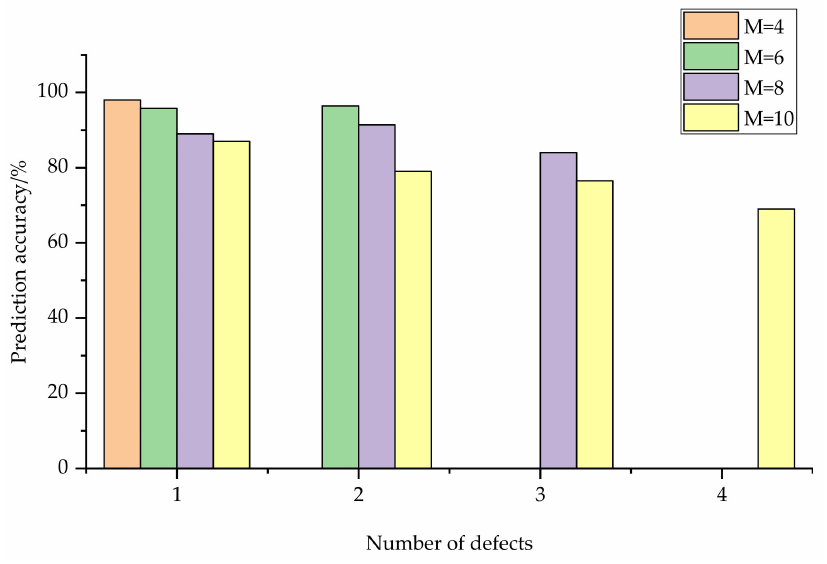
Figure 12. M module prediction